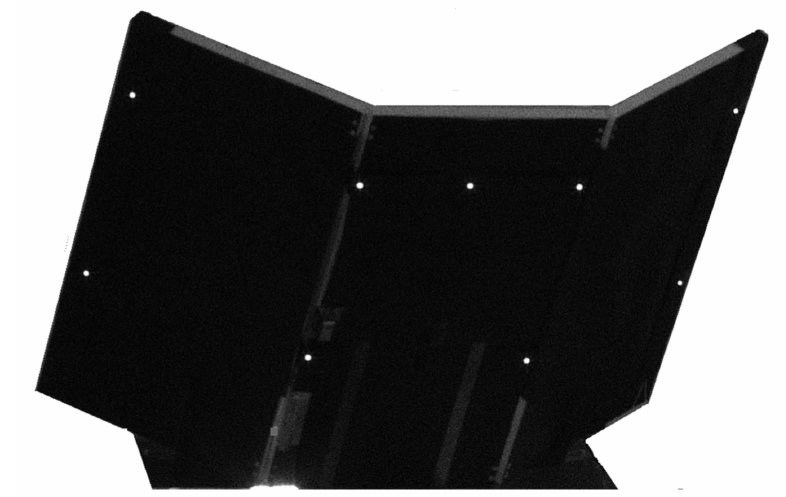
Figure 3. Beacon, check test, ω n = 20 ◦ , ψ n = 35 ◦